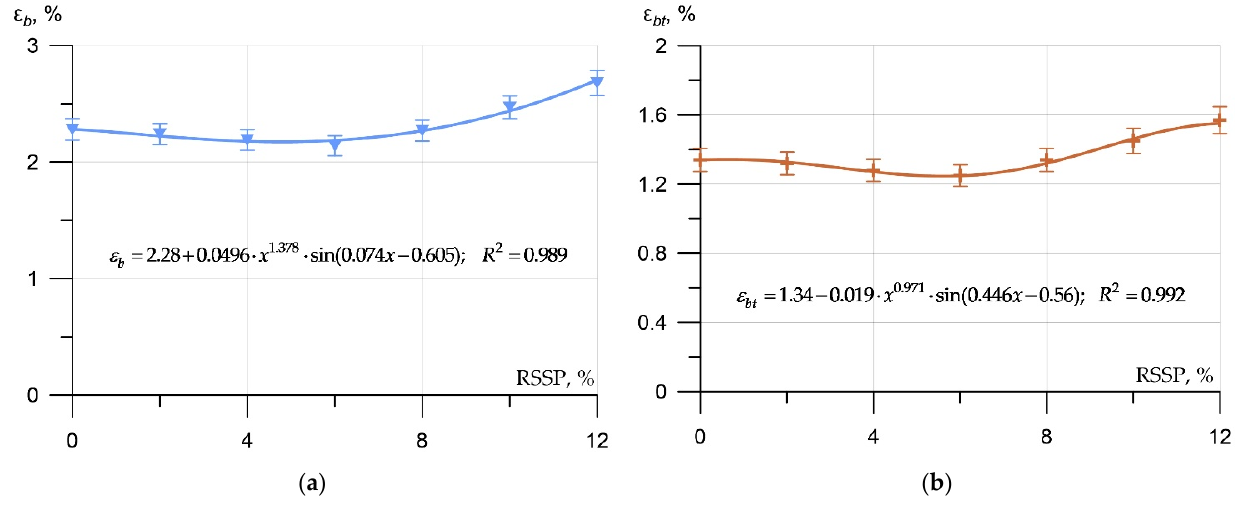
Figure 9. Strain characteristics of snail shell powder concrete: ( a ) under compression; ( b ) in tension. The dependences of the strain characteristics of concrete on the dosage of snail shell powder are approximated by formulas with determination coefficients of 0.989 and 0.992. 1.378